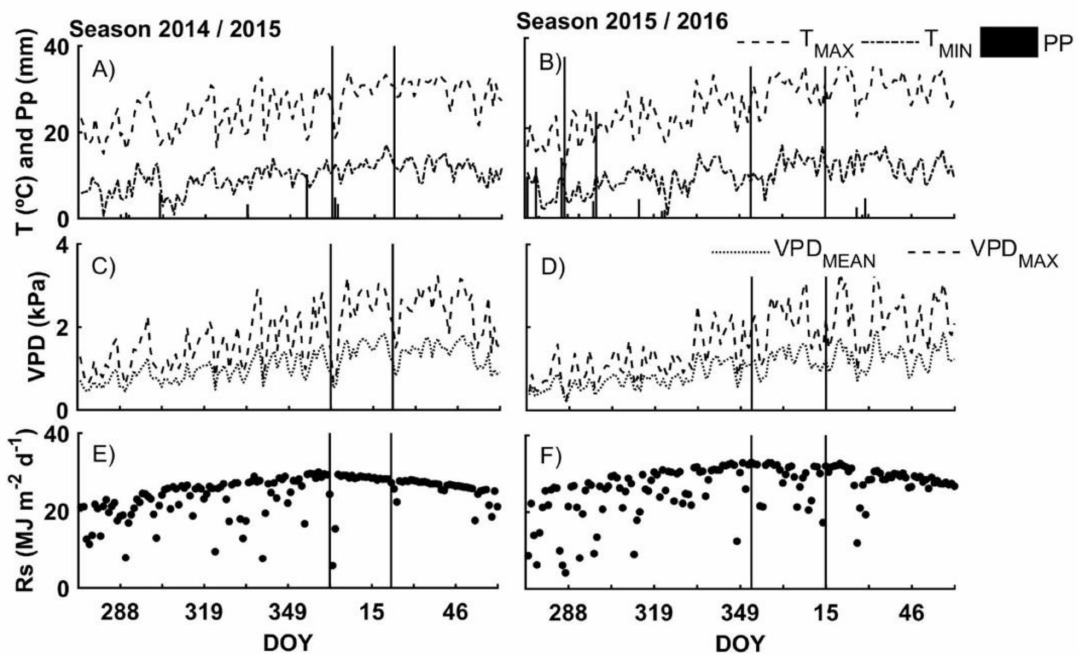
Figure 1. Maximum daily temperature (T MAX ), minimum daily temperature (T MIN ), daily precipitation (PP) ( A , B ); average daily vapor pressure deficit (VPD MEAN ), maximum daily vapor pressure deficit (VPD MAX ) ( C , D ); and daily solar radiation (Rs) ( E , F ) measured in both seasons (2014/2015 and 2015/2016). Vertical thin lines indicate the period of application of irrigation treatments. DOY is the day of